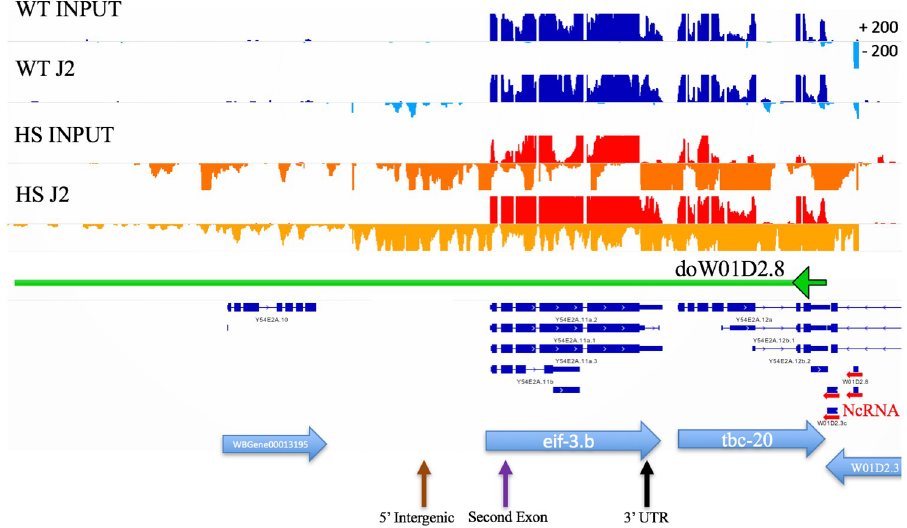
Fig 6. Heat shock induces transcripts antisense to the eif-3B locus. IGV view of eif-3 .B. Normalized tracks with the sense strand on the top part of the histogram and antisense on the bottom with a max read depth of 200 for sense or antisense. Wild type (WT) sense (dark blue), WT antisense (light blue), heat shock (HS) sense (red), heat shock antisense (orange). Horizontal blue arrows indicated genes and gene direction 5’ to 3’. Horizontal red arrows on the right show a cluster of ncRNAs including W01D2 . 8 and transcription downstream of W01D2 . 8 (doW01D2 . 8) into eif- 3 . B (green arrow going left). Arrows on the bottom correspond to locations of probes for FISH (brown: 5’ Intergenic, purple: Second exon, black: 3’ UTR).